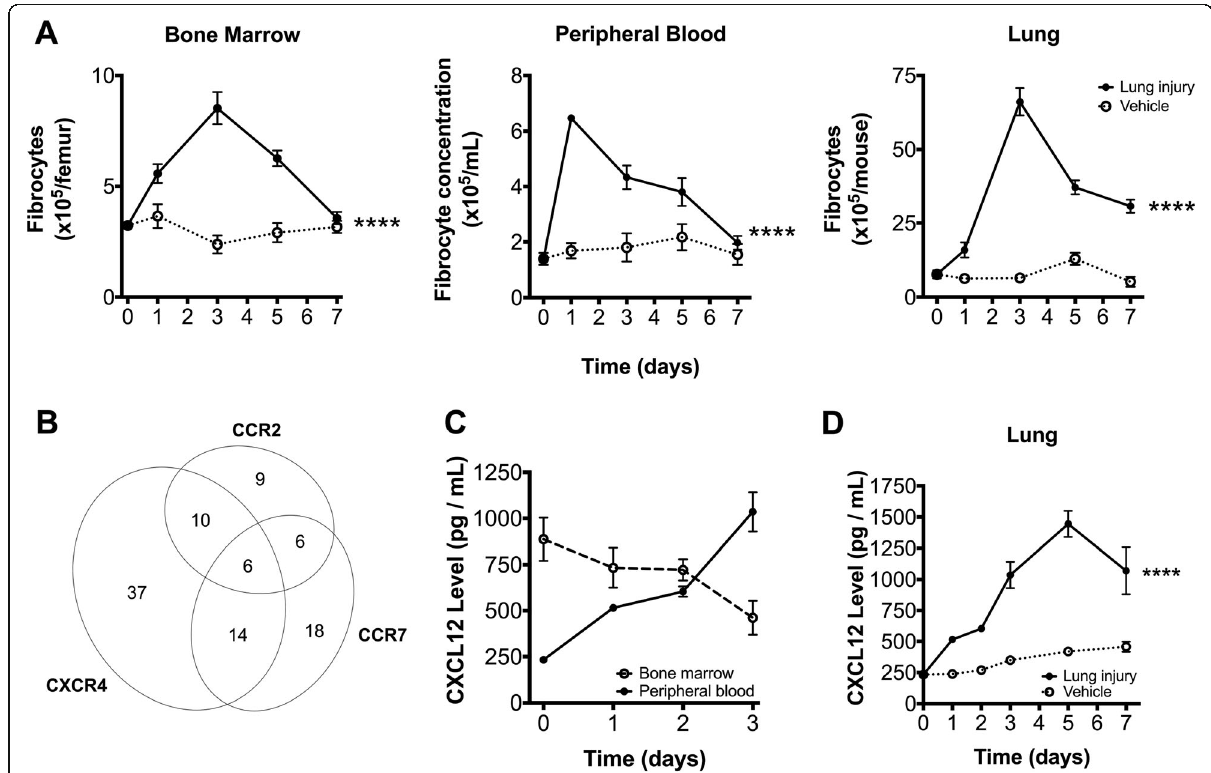
Fig. 2 Fibrocytes in murine acute lung injury caused by Gram-negative pneumonia. a Concentration of fibrocytes in the bone marrow, blood, and lung compartments after onset of acute lung injury. b Distribution of median percentage of lung fibrocytes expressing chemokine receptors on day 3 acute lung injury. c - d Concentration of CXCL12 in the bone marrow, peripheral blood, and lung after onset of acute lung injury. Panels A, C, and D show data as mean ± SEM. All data is representative of 5 – 6 animals per group and per time point. *, p < 0.05; ****, p < 0.0001 by 2- way ANOVA (panels a , d ) and Kruskal-Wallis test (panel c